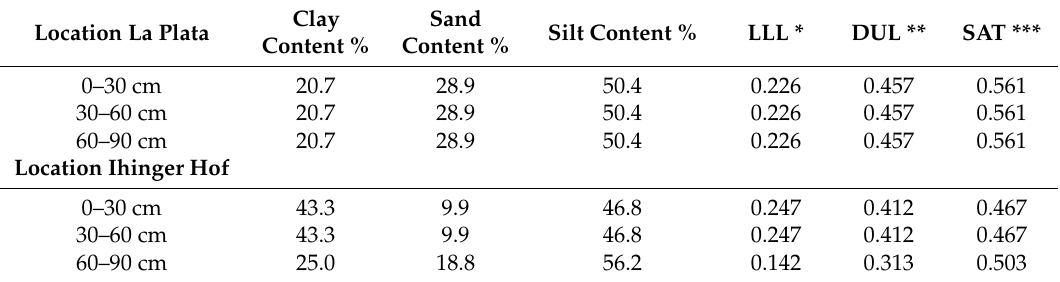
Table 1. Soil properties for experiments in La Plata and Ihinger Hof used in the